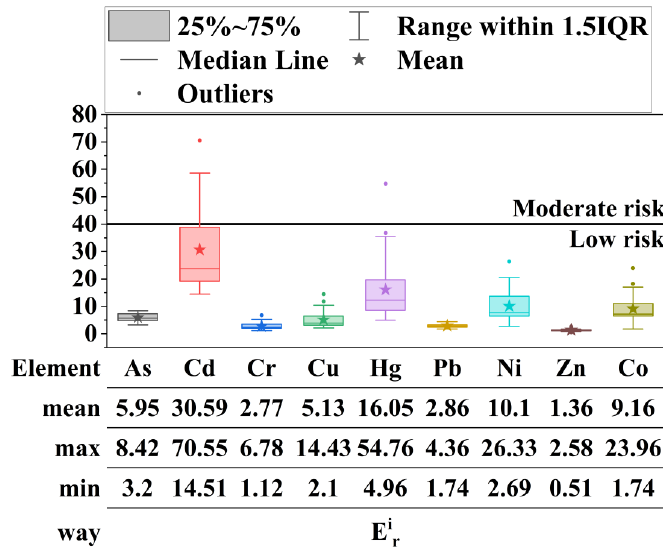
Figure 7. The result of the overall individual potential ecological risk index (E i r ) of each heavy metal element within 0–100 cm of wetland